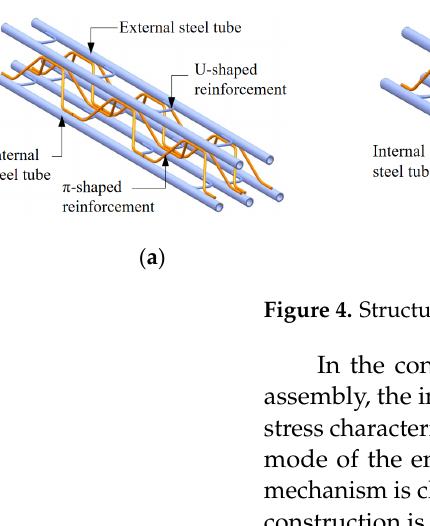
Figure 4. Structural types of the SRS arch: ( a ) five-leg, ( b ) seven-leg, ( c ) nine-leg.